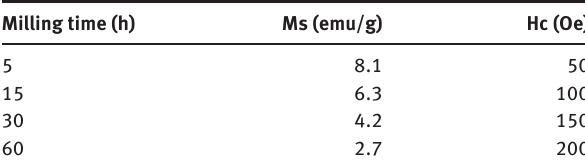
Table 1: Summary of the magnetic properties of CuFe alloy particles. Milling time (h)